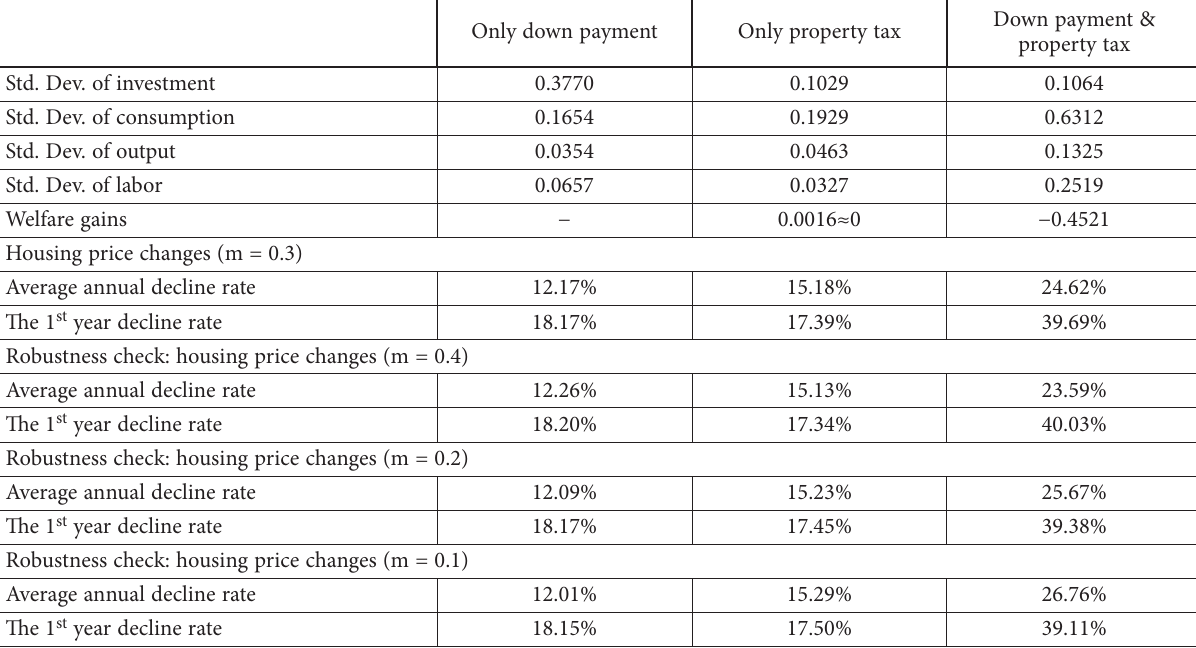
Table 6. Macroeconomic stability and welfare under alternative policy regimes Only down